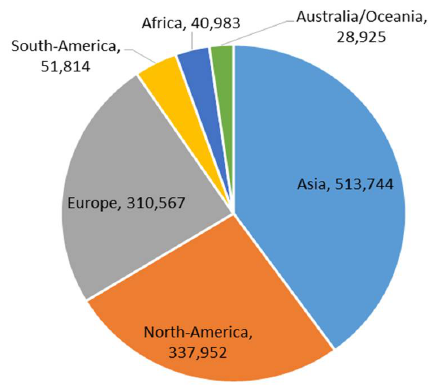
Figure 4. Mass [metric tons] of Aircraft worldwide according to the continent of operation.